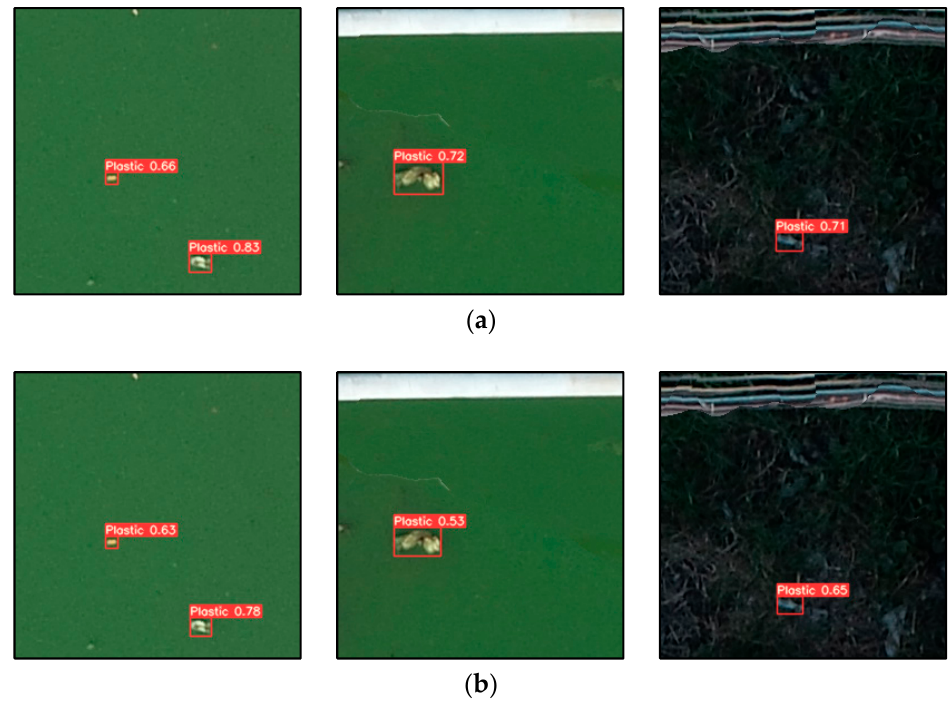
Figure 8. Fine-tuning the HMH model on TT is weak in some cases. ( a ) TT model result on TT. ( b ) HMH model results on TT with fine-tuning. Transfer learning confidence scores are lower. (Note: bar-like objects are galvanized stainless steel roof sheets).